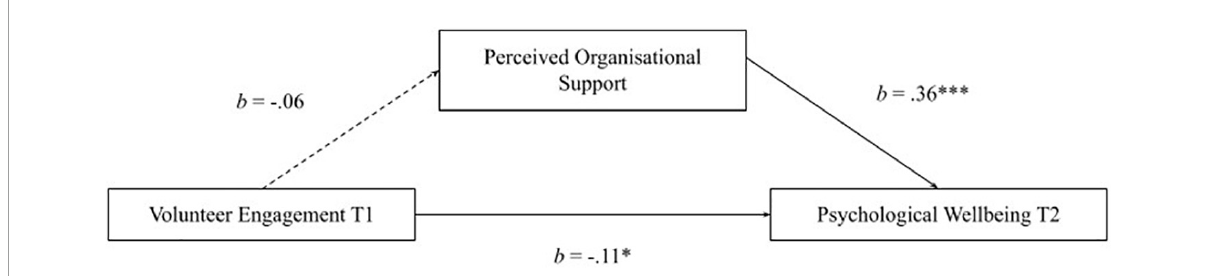
FIGURE4 No mediation model of volunteer engagement Tl and psychological wellbeing T2 through perceived organizational support. No mediation in the model, n = 202. Unbroken lines are direct significant pathways between variables; broken lines represent indirect pathways between variables. Unstandardized effects are shown and represented by b values. ∗ p < 0.05, ∗∗∗ p < 0.001.